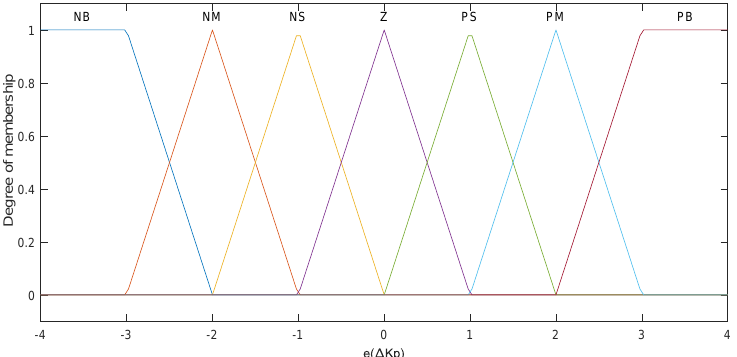
Figure 8. Membership function curve of various e and ∆ K p .